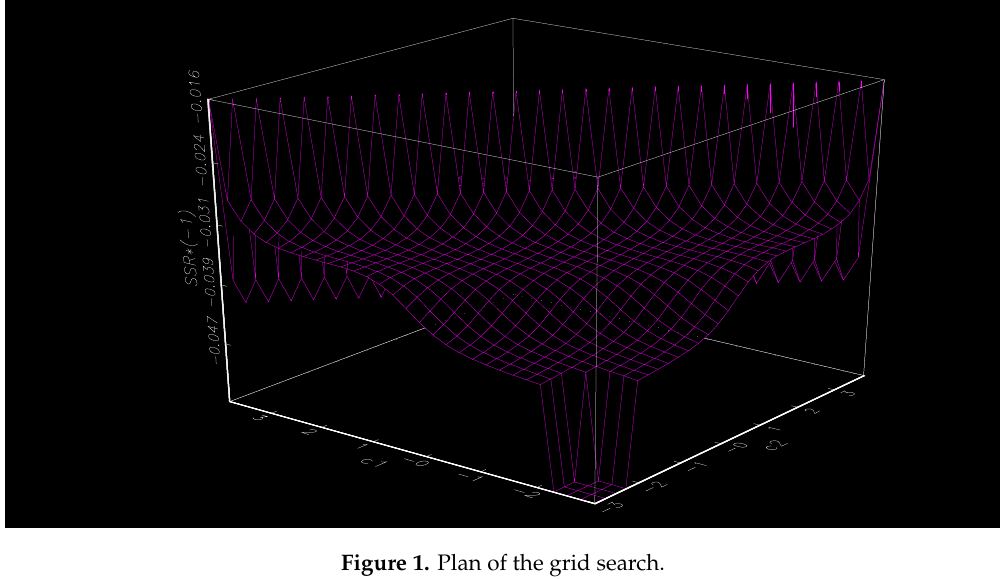
Figure 1. Plan of the grid search.